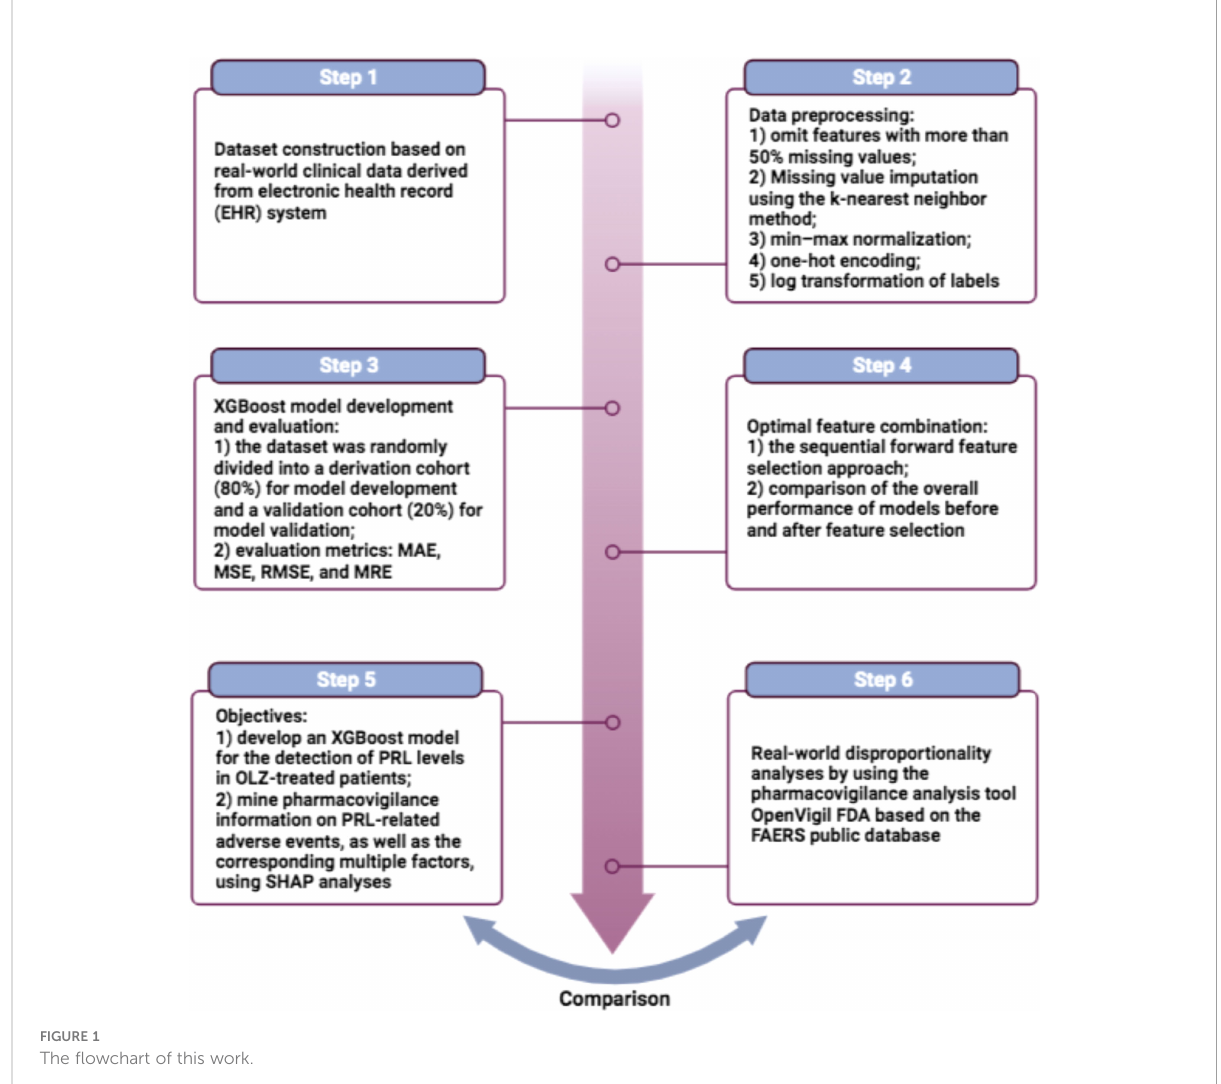
FIGURE 1 The fl owchart of this